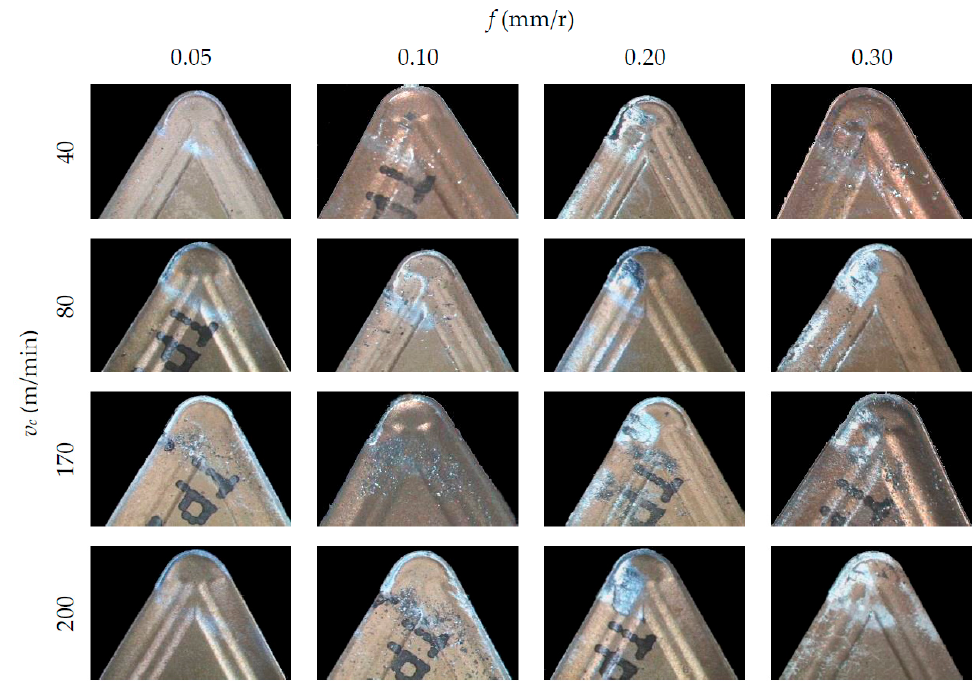
Figure 5. SOM images (30×) of the rake face, for a p = 1 mm.